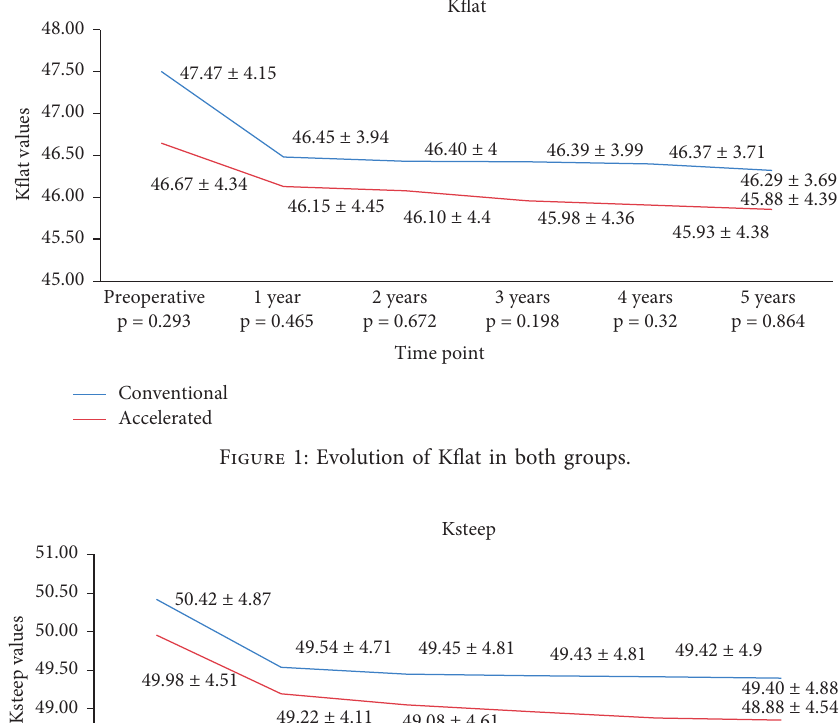
Figure 1: Evolution of Kflat in both